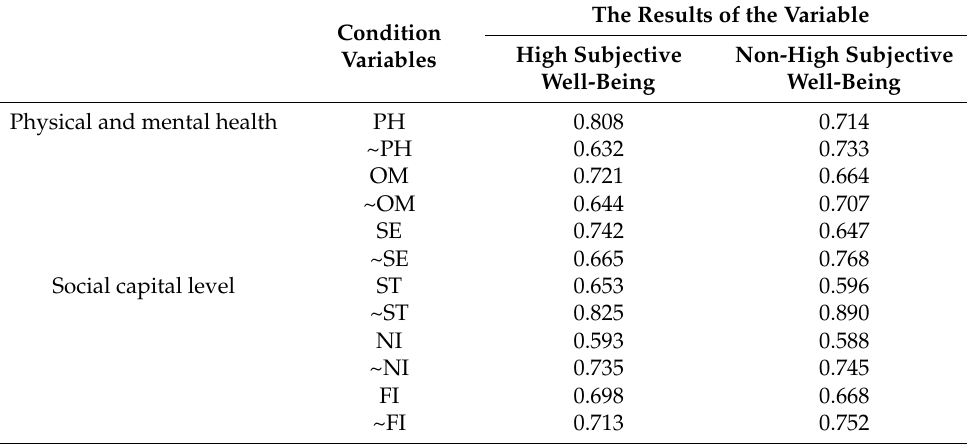
Table 3. Necessity analysis of subjective well-being.